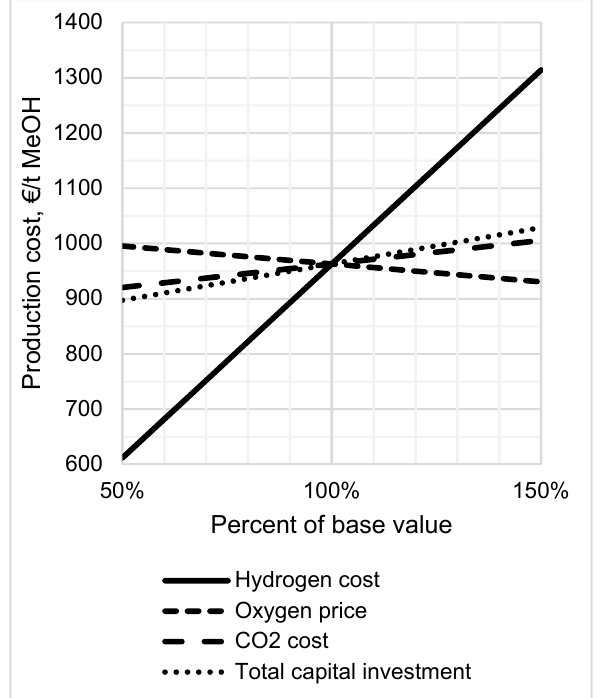
Figure 8. Sensitivity of methanol production cost to variations in selected parameters in the gas-phase methanol synthesis process. Base values: hydrogen cost 3000 €/t, oxygen price 70 €/t, CO 2 cost 50 €/t, total capital investment 17.9 M€.